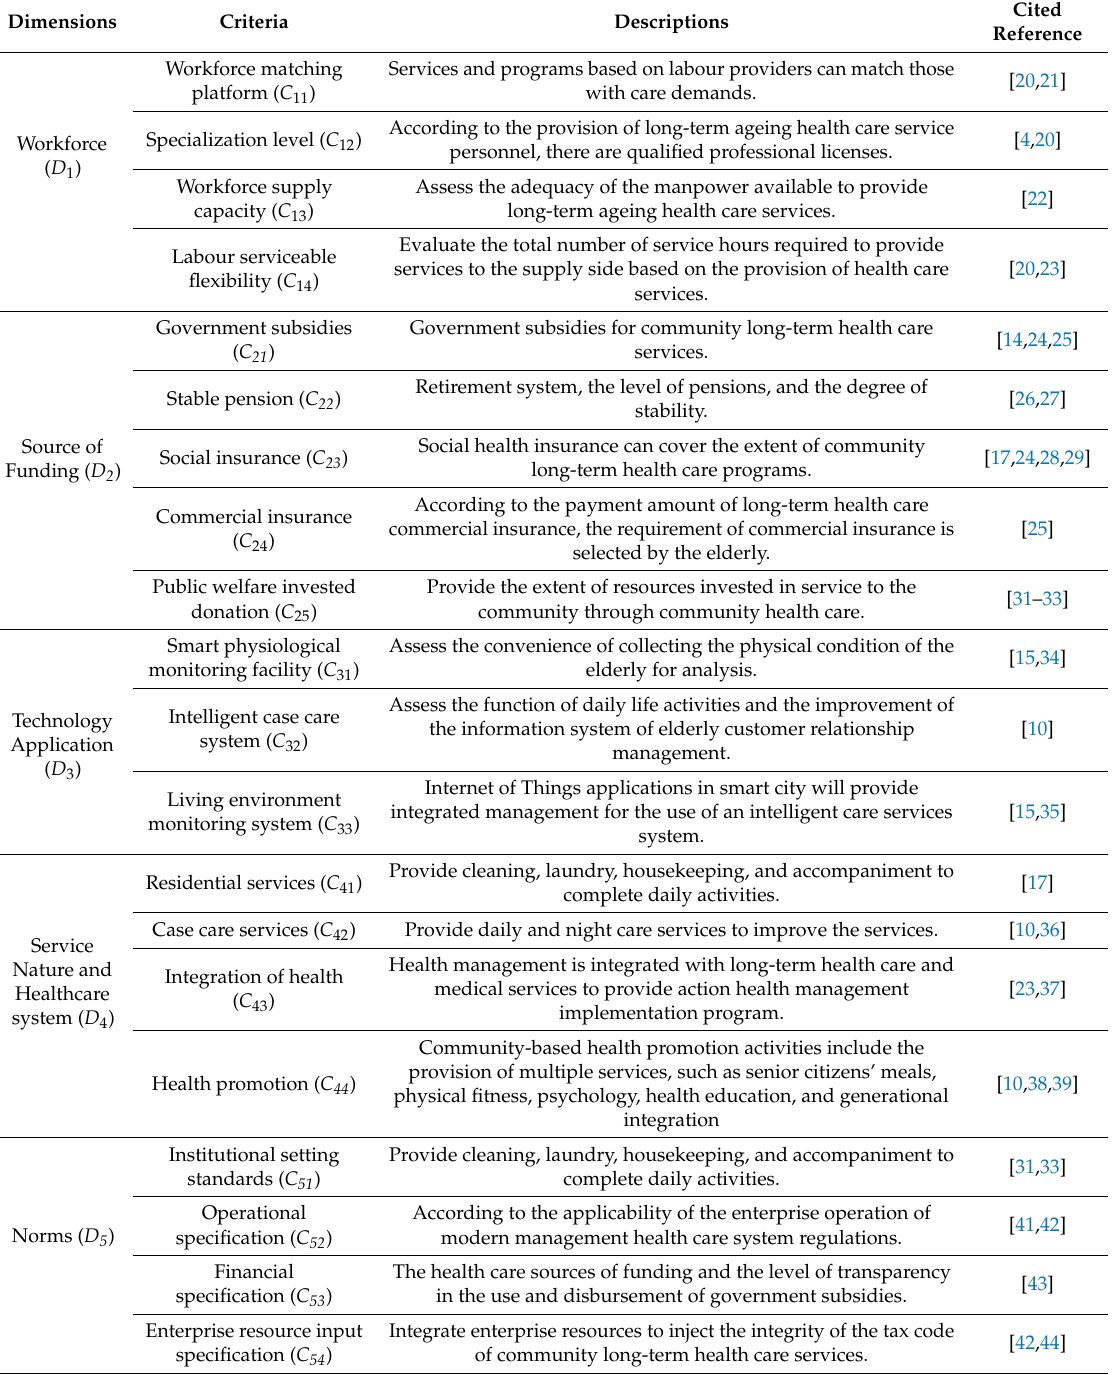
Table 1. Evaluation framework long-term ageing health care in